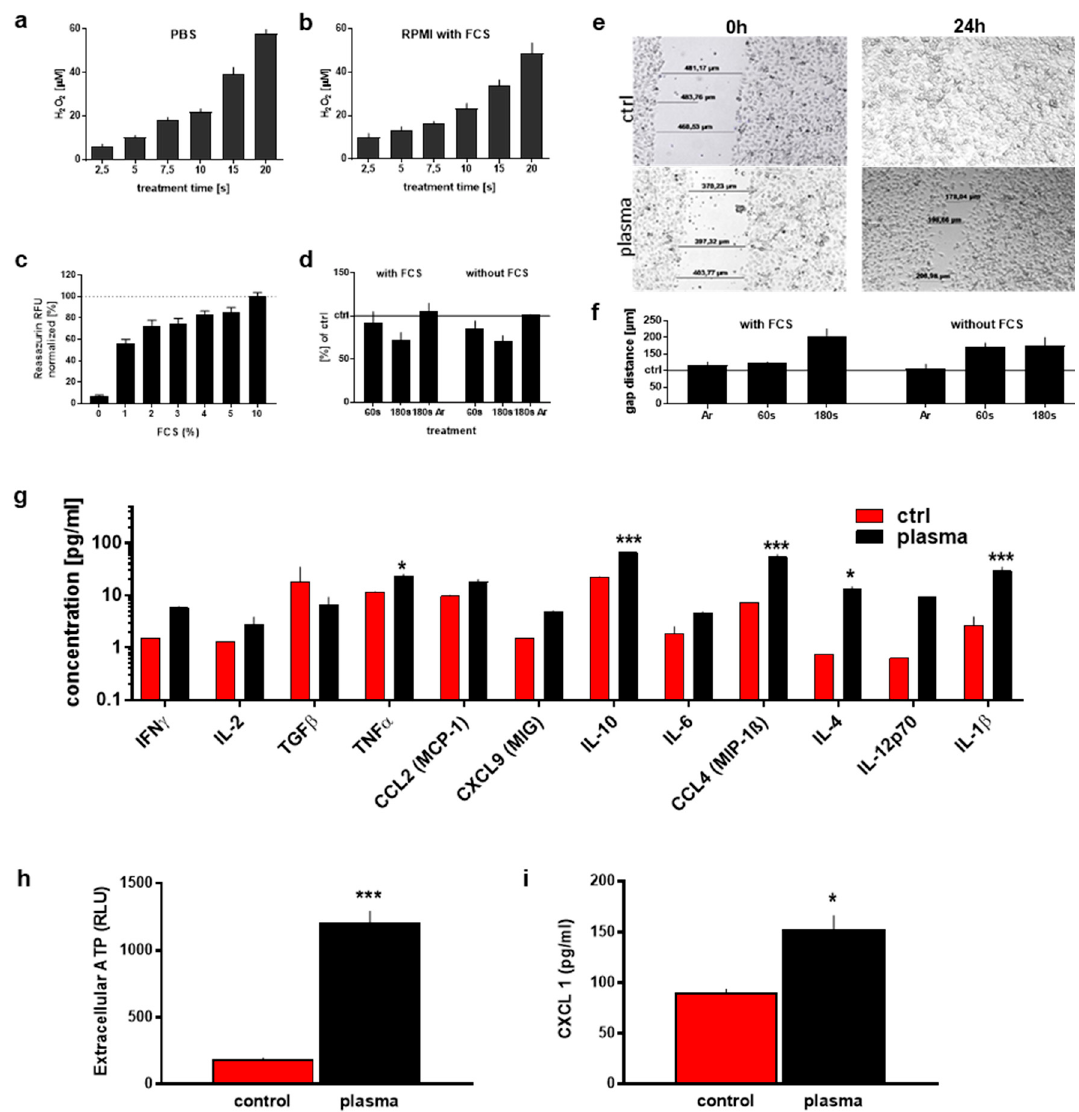
Figure 1. Effects of plasma treatment in liquids and treatment of B16F10 melanoma cells with physical plasma. ( a ) Plasma deposited hydrogen peroxide in PBS and ( b ) cell culture medium at nearly similar levels; ( c ) growth behavior of melanoma cells under different concentration of FCS; ( d ) reduction of metabolic activity in melanoma cells after plasma treatment in cell culture medium with or without FCS, normalization was done with respect to a control in each condition; ( e ) representative images of scratches in control or 180 s plasma-treated melanoma cells after 0 h or 24 h, respectively, and ( f ) their normalized regrowth quantified; ( g ) cytokine/chemokine profile of plasma-treated melanoma cells; ( h ) release of the danger molecules ATP and ( i ) CXCL1 in plasma-treated melanoma cells. ( a – d , f ) Data are mean +S.E. from several replicates; statistical analysis was performed using t-test; PBS: phosphate-buffered saline; FCS: fetal calf